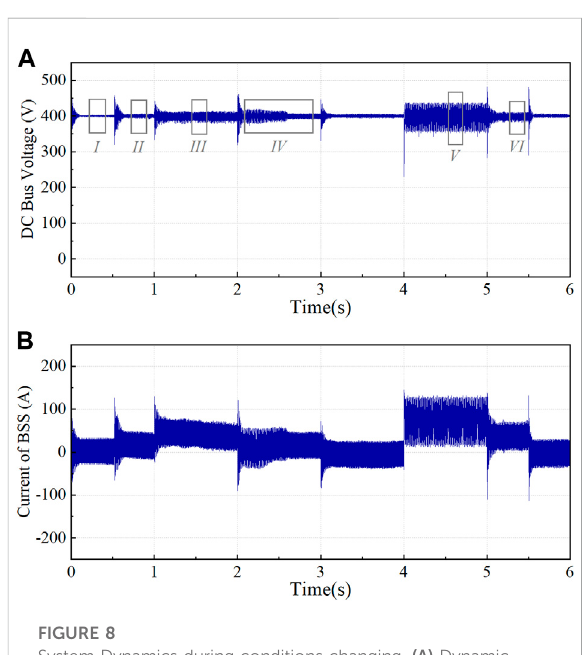
FIGURE 8 System Dynamics during conditions changing. (A) Dynamic of DC bus voltage. (B) Dynamic of BSS